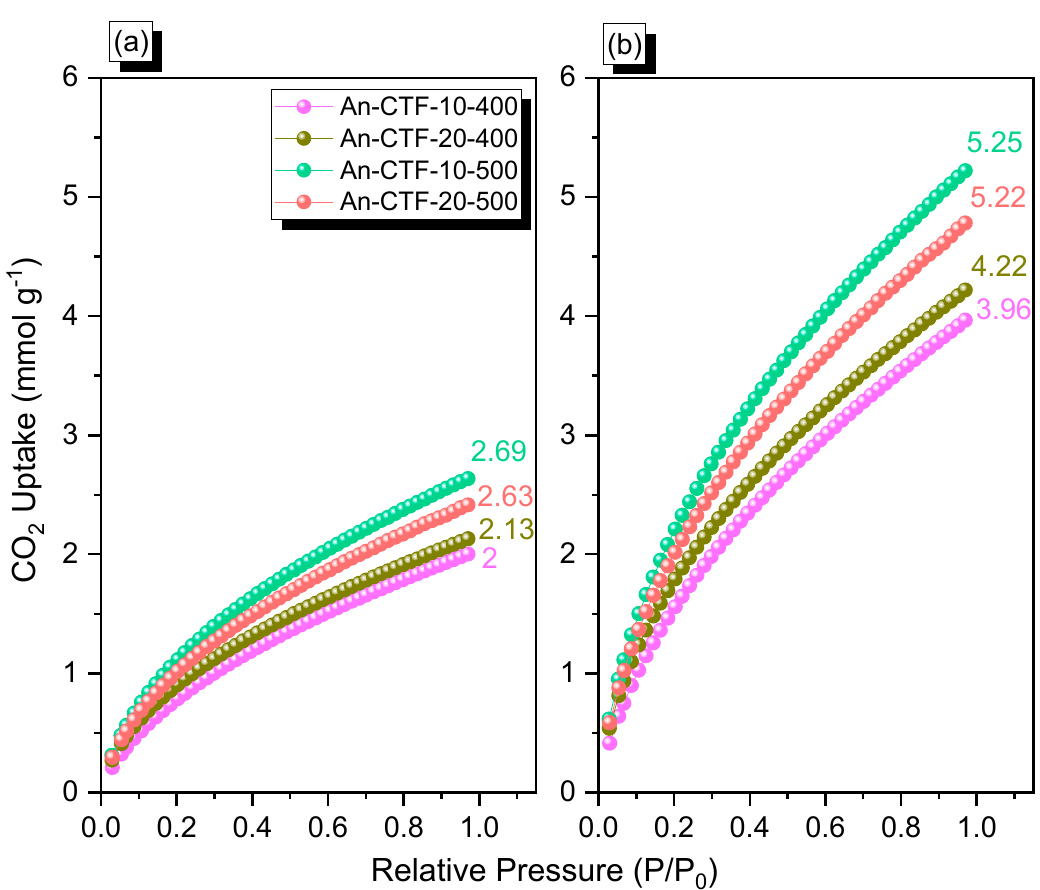
Figure 6. CO 2 adsorption performance of An-CTF-10-400, An-CTF-20-400, An-CTF-10-500, and An-CTF-20-500, recorded at 298 K ( a ) and 273 K ( b ).